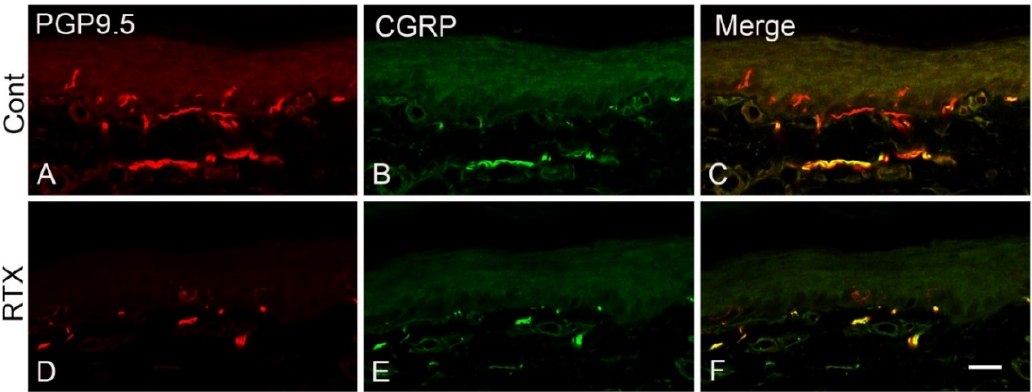
Figure 11. Effect of intraplantar injection of RTX (0.002%) in the hind paw on the distribution of PGP 9.5- and CGRP-labelled nerves in the injected skin. Panels ( A – C) show normal PGP 9.5- and CGRP-labelled nerves in the vehicle-injected rats. RTX injection decreased the number of both PGP 9.5- and CGRP-labelled nerves ( D – F ). Scale bar 25 µm.